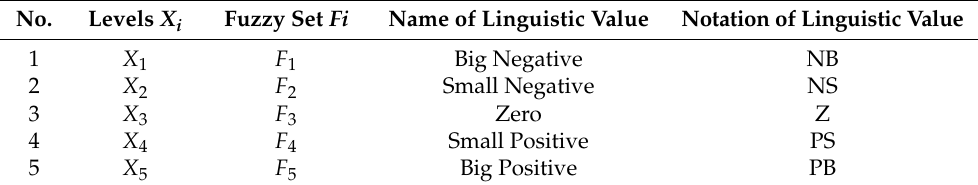
Table 2. Description of levels of the discretized universe of discourse, fuzzy sets, linguistic value terms, and notations, of the inputs and